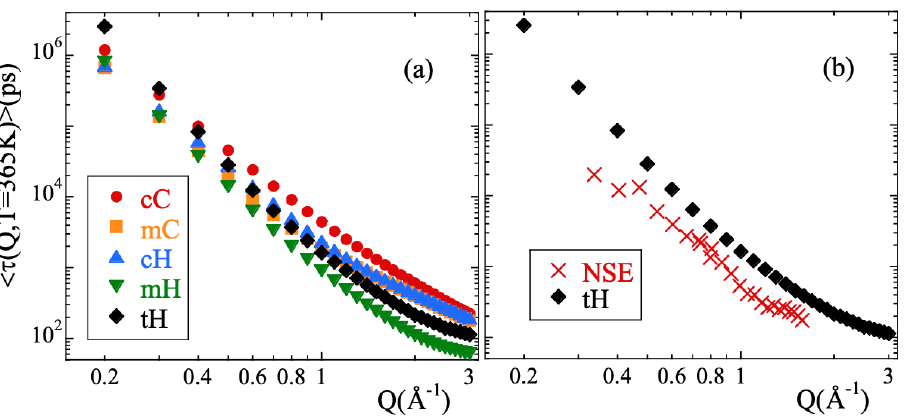
Figure 4. Momentum transfer dependence of the average characteristic times obtained at 365 K for ( a ) the different atomic species and ( b ) for the total hydrogens compared with the experimental NSE results reported in Ref.